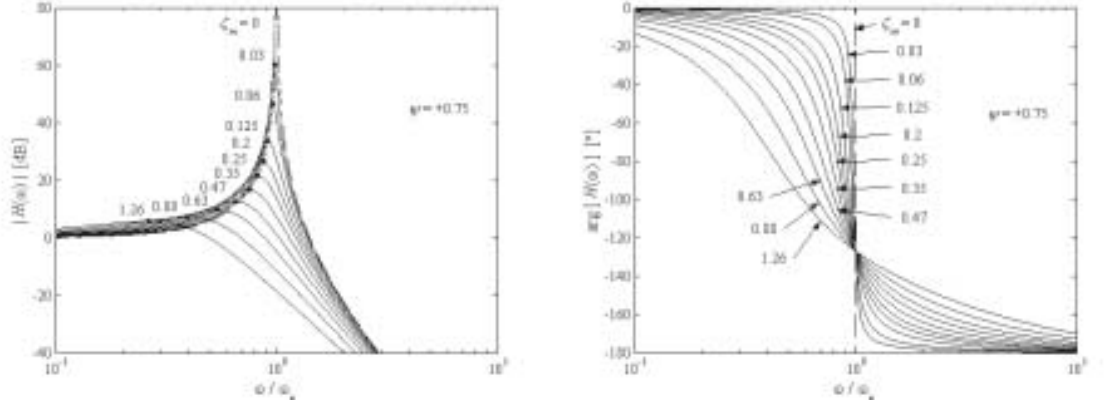
Fig. 12. Modulus (left) and phase (right) of FRF for ψ = 0 . 75 .